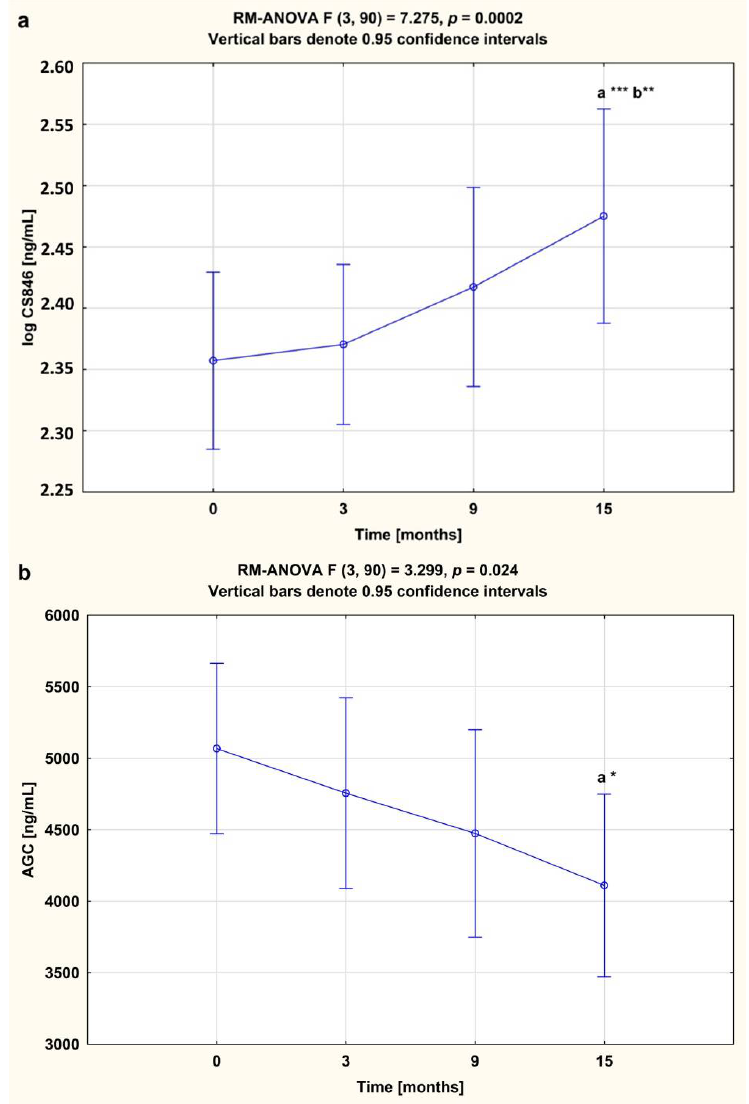
Figure 3. Temporal course of serum CS846 ( a ) and AGC ( b ) levels in RA patients during 15-month anti-TNF- α therapy. Results expressed as mean (standard deviation, SD). Data not normally distributed (CS846) was log-transformed prior to analyses. Data analyzed using one-way repeated measures analysis of variance (RM-ANOVA), followed by Tukey’s multiple comparisons test. a statistically significant di ff erences compared to baseline; b statistically significant di ff erences compared to 3 months after therapy. * p < 0.05; ** p < 0.01; *** p < 0.001. AGC, aggrecan fragments; CS846, chondroitin